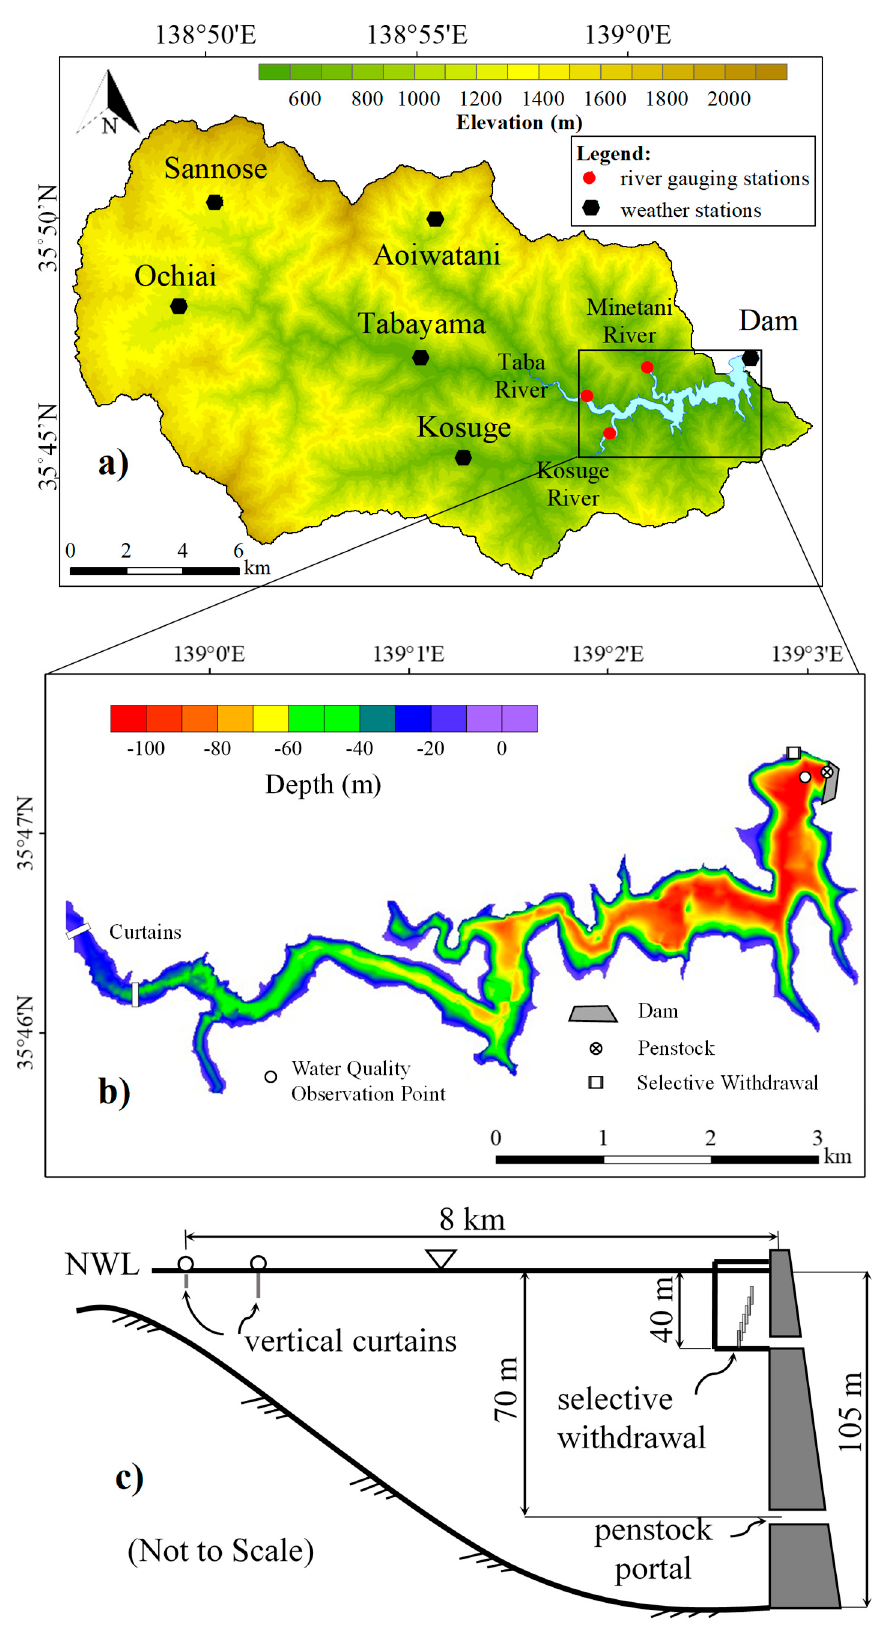
Figure 1. Maps of ( a ) the Ogouchi catchment, ( b ) reservoir bathymetry, and ( c ) dam and reservoir profile.